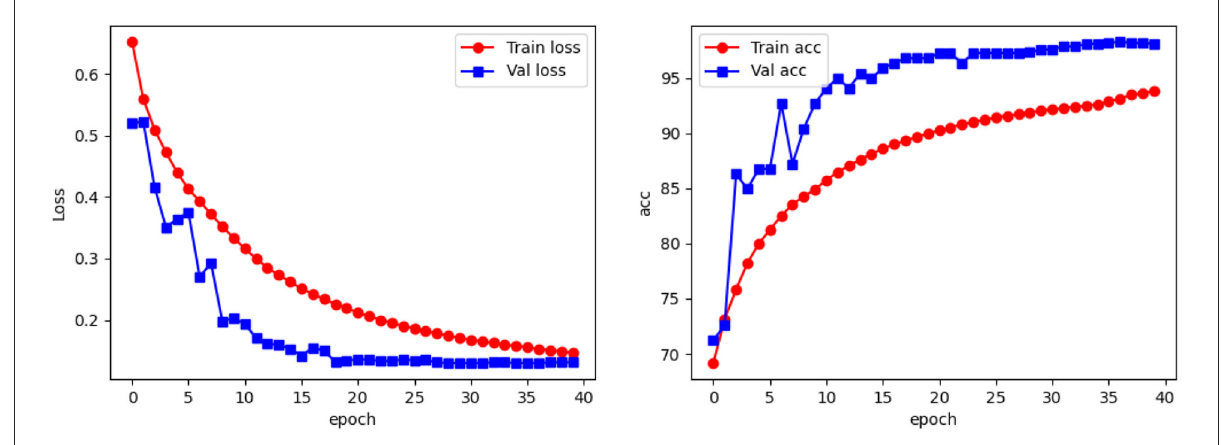
FIGURE7 Accuracy of the network vs. loss function line graph.